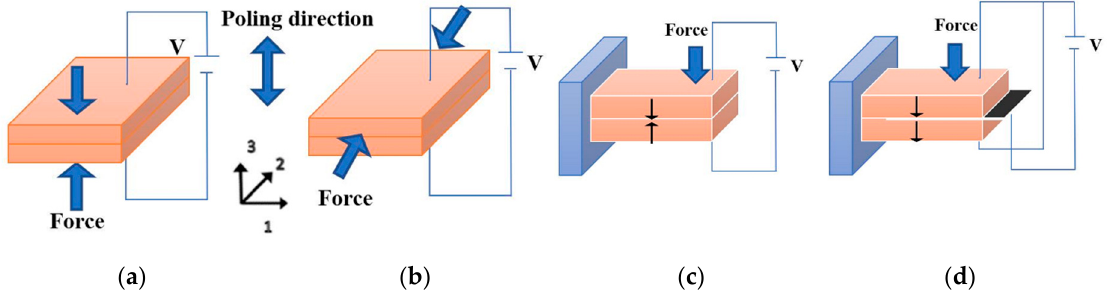
Figure 2. ( a ) d 33 mode piezoelectric material operation, ( b ) d 31 mode piezoelectric material